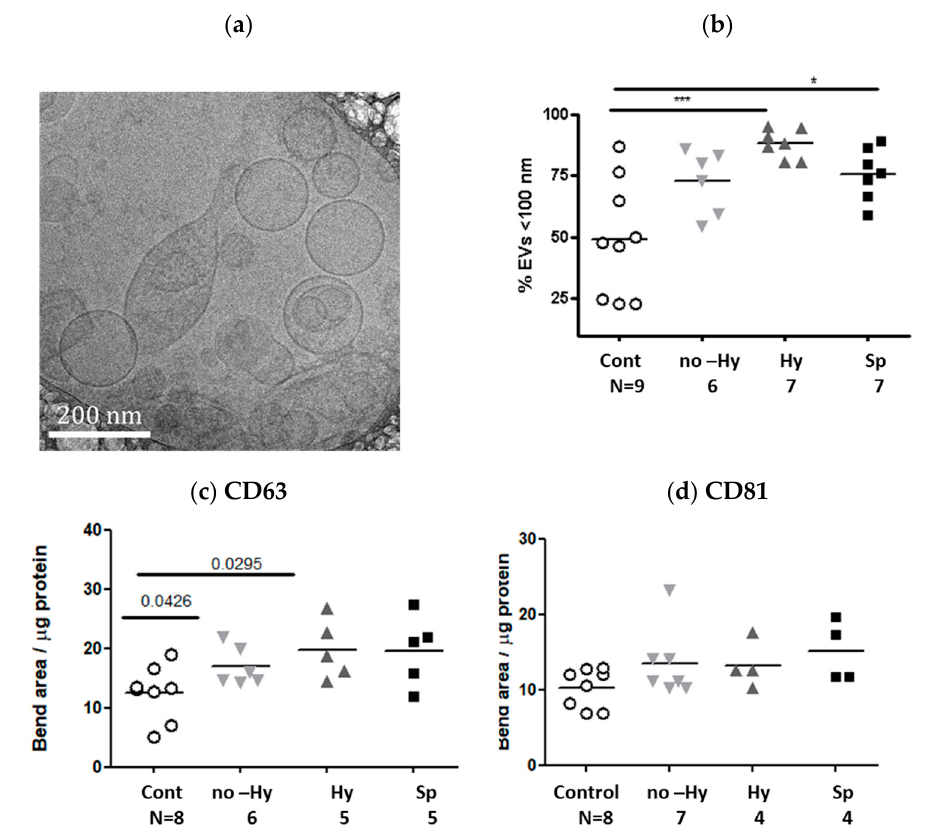
Figure 1. Extracellular vesicle (EV) size distribution and expression of exosome markers. ( a ) Cryogenic transmission electron microscopy, a representative image of an EV pellet from a participant in the β T group, showing a heterogeneous population of EVs. ( b ) The size distributions of EVs obtained from the healthy controls and the patient subgroups were measured by nanoparticle-tracking analysis. The graph presents the percentage of small EVs (<100 nm) in each sample. N = the number of patient samples that were validated in each subgroup. ( c , d ) The expression levels of EV markers (CD63 and CD81) were determined by densitometry of western blot of samples isolated from the control group and the three β T subgroups: no hypersplenism (no-Hy), hypersplenism (Hy), and splenectomized (Sp). ( c ) Expression of EV CD63. ( d ) Expression of EV CD81. * p < 0.05, *** p < 0.001.